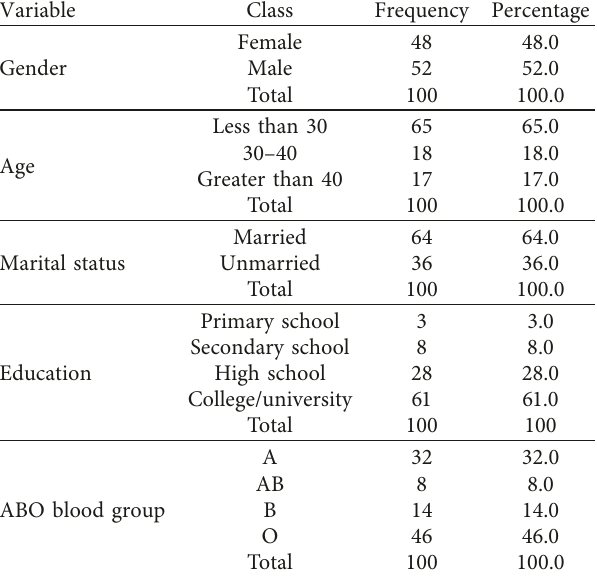
Table 1: Frequency and percentage distribution of patients based on